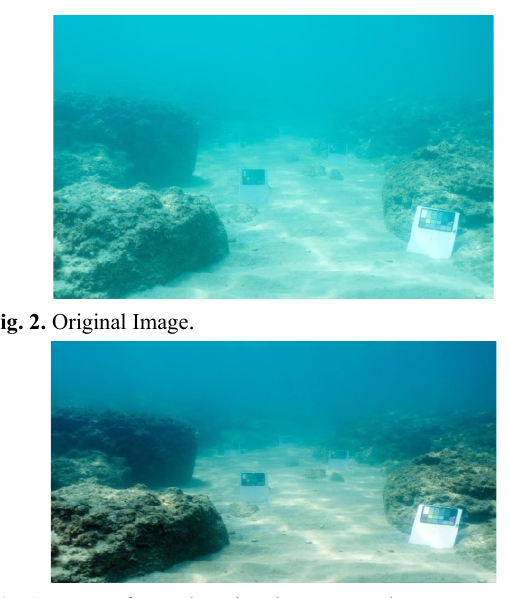
Fig. 3. Image after undergoing the Image Enhancement .